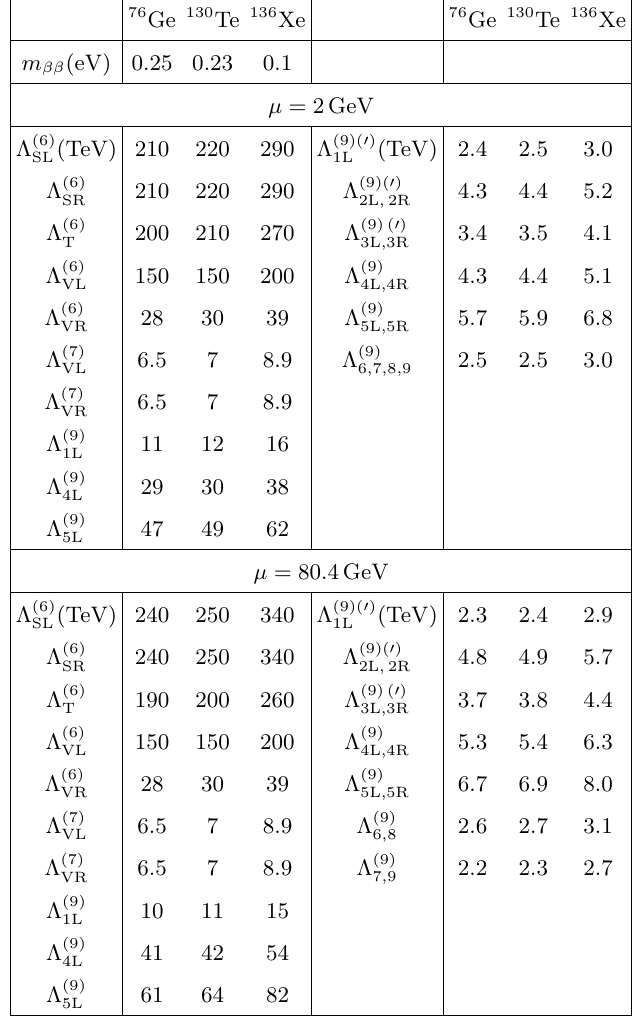
Table 5 . The table shows the upper limits on the dim-6, dim-7, and dim-9 operators from the GERDA [11], CUORE [10], and KamLAND-Zen [5] experiments. In the left column, we assume C ( d )